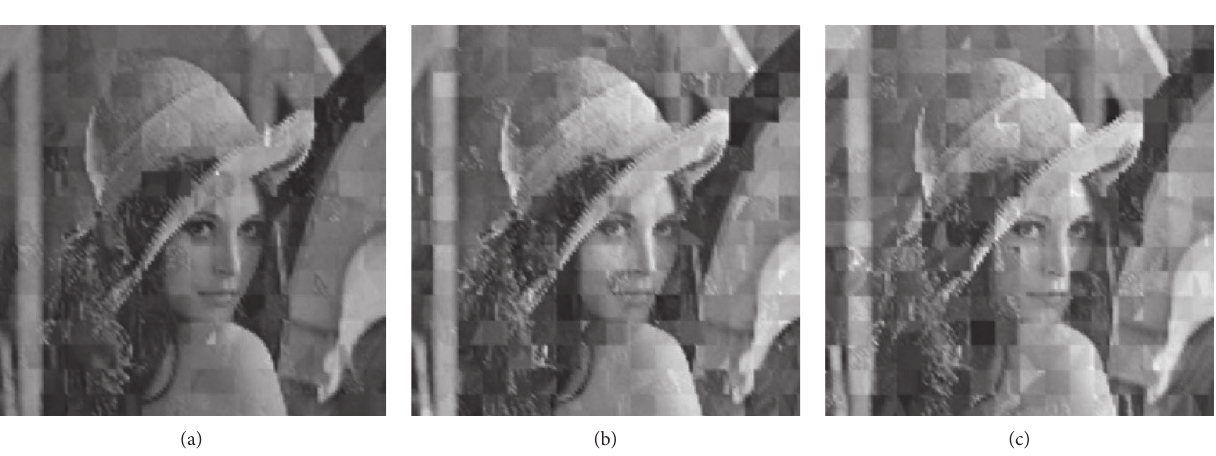
Figure 11: The decrypted images when the phase mask matrices are attacked by noise, and the measurement is 3000. (a) Gaussian noise: � 0 . 9549. (b) Salt and pepper noise: density is 0.005 and r mean value is zero, variance is 0.005 and r TG � 0 . 9119. zero, variance is 0.01, and r TG